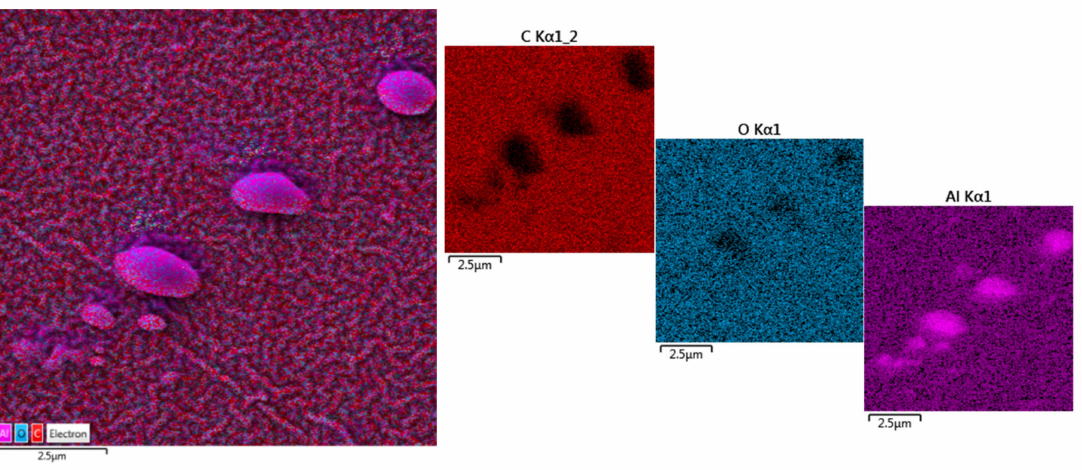
Figure 7. SEM-EDX images of Al deposited COC on the